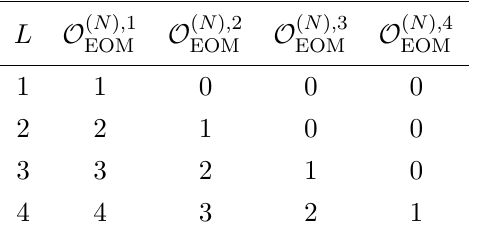
into O ( N ) ,k is required, 1 EOM